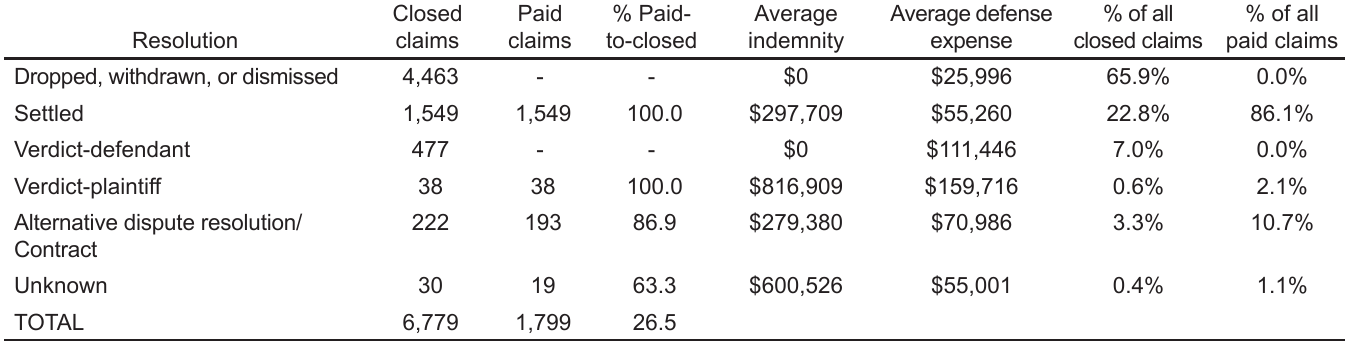
Table 2. Resolution and outcomes of closed claims in adult emergency departments or urgent care